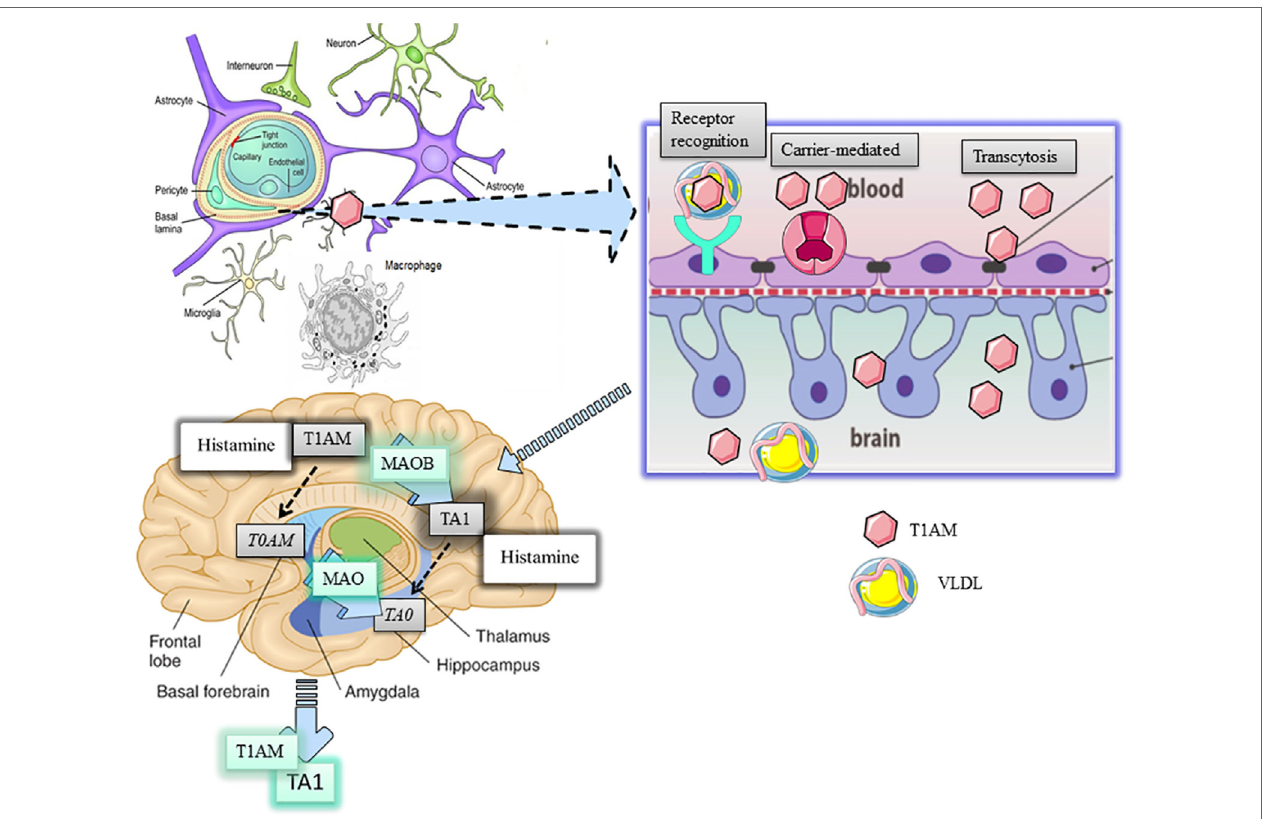
FiGURe 1 | Distribution and metabolism of 3-iodothyronamine (T1AM) in the brain. T1AM is physiologically present in the brain of mice and its levels increse after pharmaoclogical administrtaion thus indicating T1AM can pass the blood brain barrier (BBB). The mechanism of T1AM passage through the BBB remains elusive yet. Three possible hypotheses are presented, including endocytosis of lipoprotein receptor, carrier-mediated transport, or transcytosis of free T1AM. One inside the brain, T1AM is manly metabolized to 3-iodothyroacetic acid (TA1) by the activity of mitochondrial monoamine oxidases